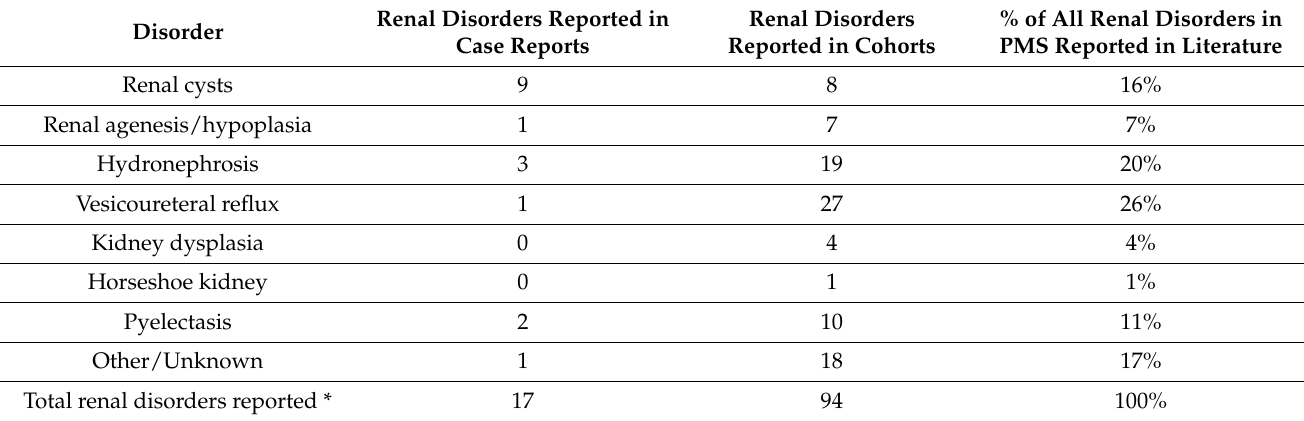
Table 3. Summary of types of renal disorders in individuals with Phelan-McDermid Syndrome as reported in the